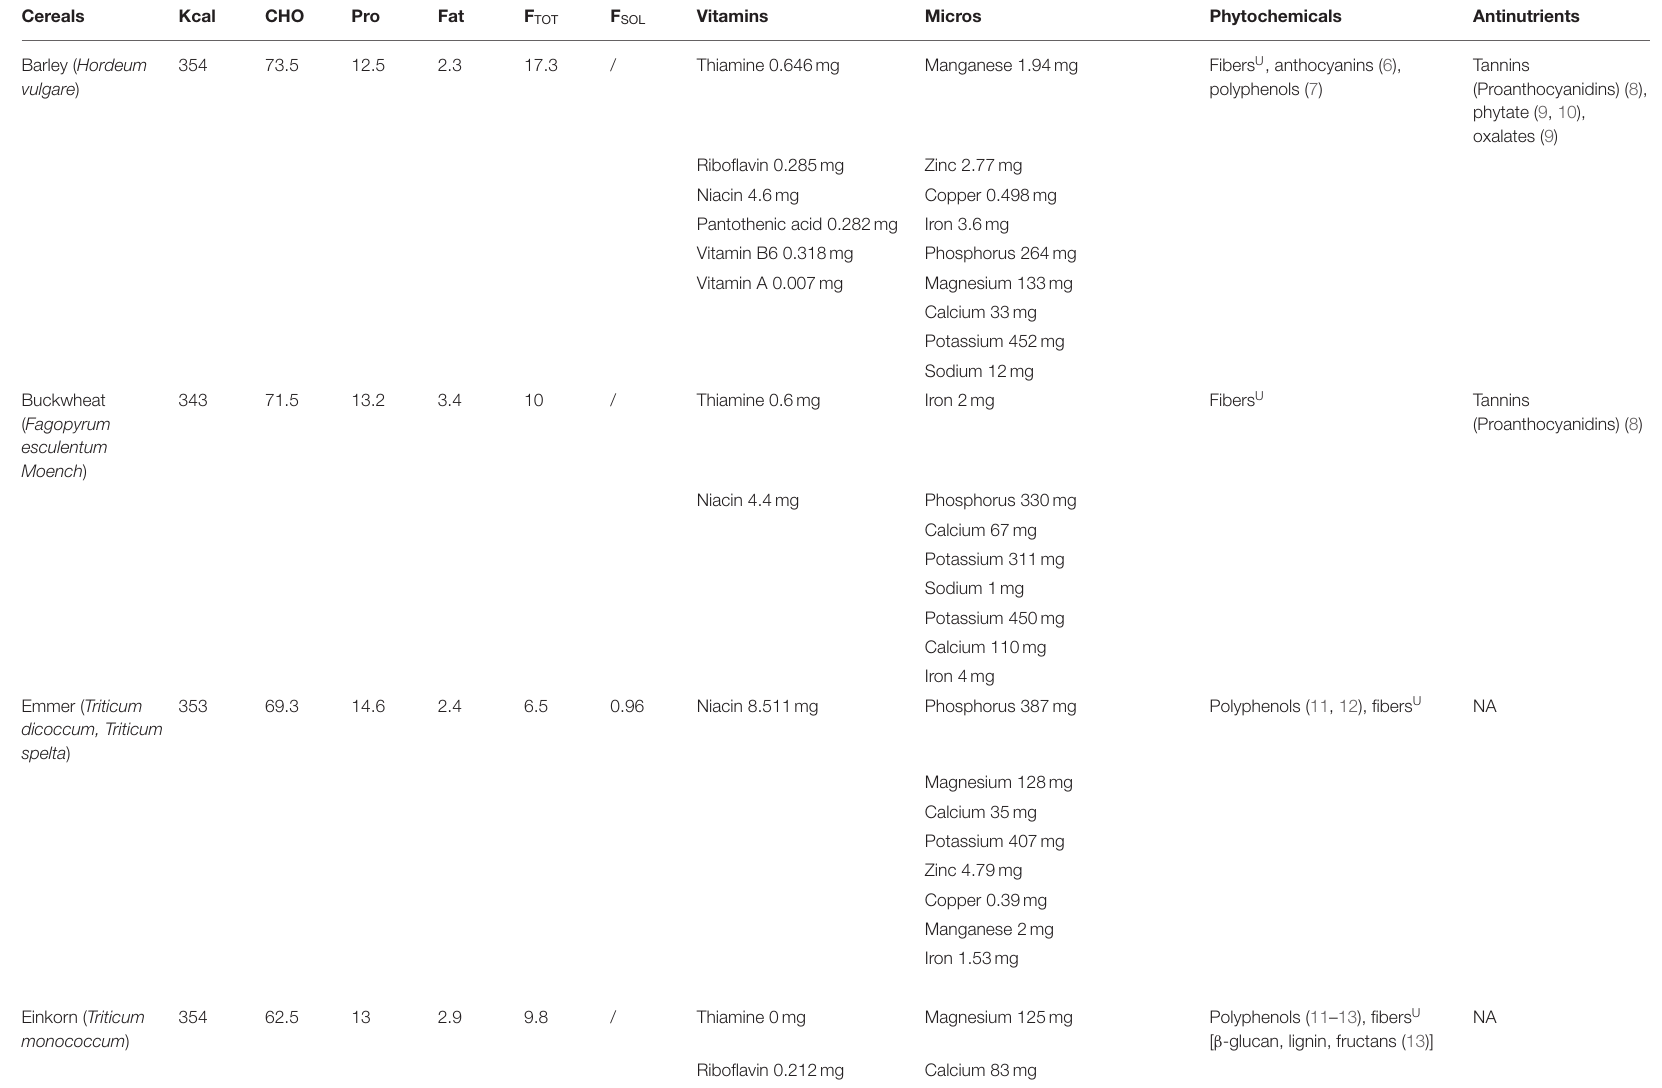
TABLE 1 | Nutrients of cereals and pseudocereals. Cereals Kcal CHO Pro Fat F TOT F SOL Vitamins